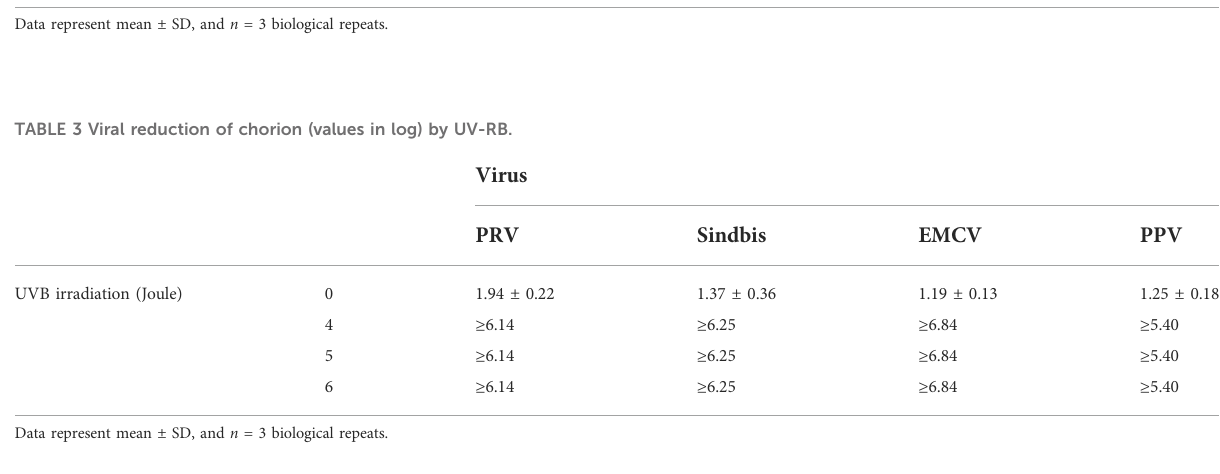
Data represent mean ± SD, and n = 3 biological repeats.